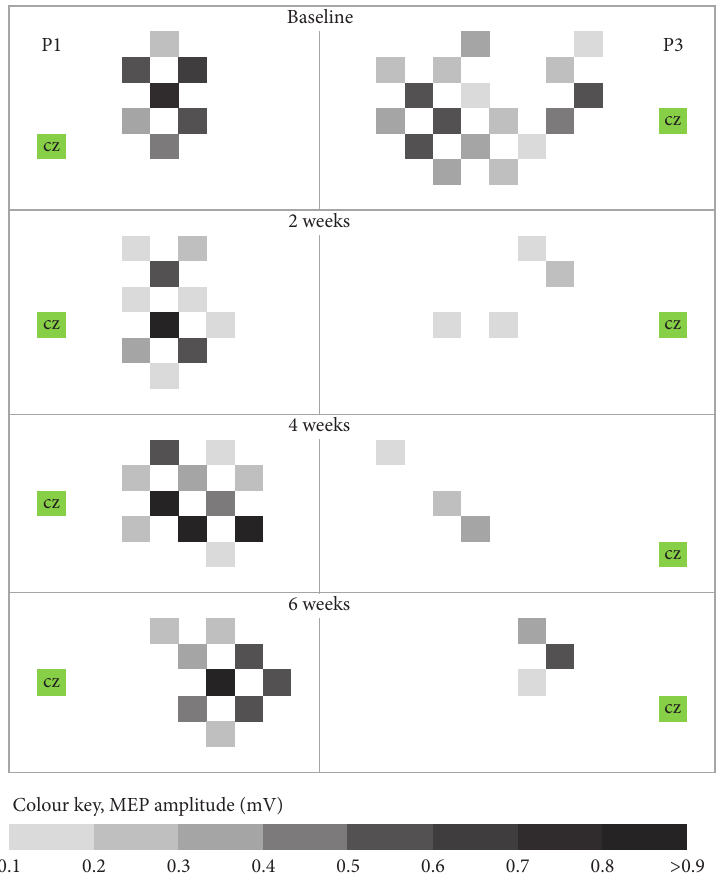
Figure 5: Hand motor representation area (MMA) within the contralesional hemisphere at baseline and its changes after six weeks in two representative patients. P3 shows a good motor recovery of the affected hand between baseline and the six-week evaluation (WMFT score increases by 16 points; ARAT score increases by 19 points). This was associated with a decrease in size and volume of contralesional MMA, as well as with an anterior-medial shift of hand motor representation. P1 shows a poor motor recovery of the affected hand at the six-week evaluation (WMFT score and ARAT score did not change). This was associated with an increase in size and volume of contralesional MMA and a posterior-lateral shift of hand motor representation. A = anterior direction; Cz = vertex; P = posterior direction.